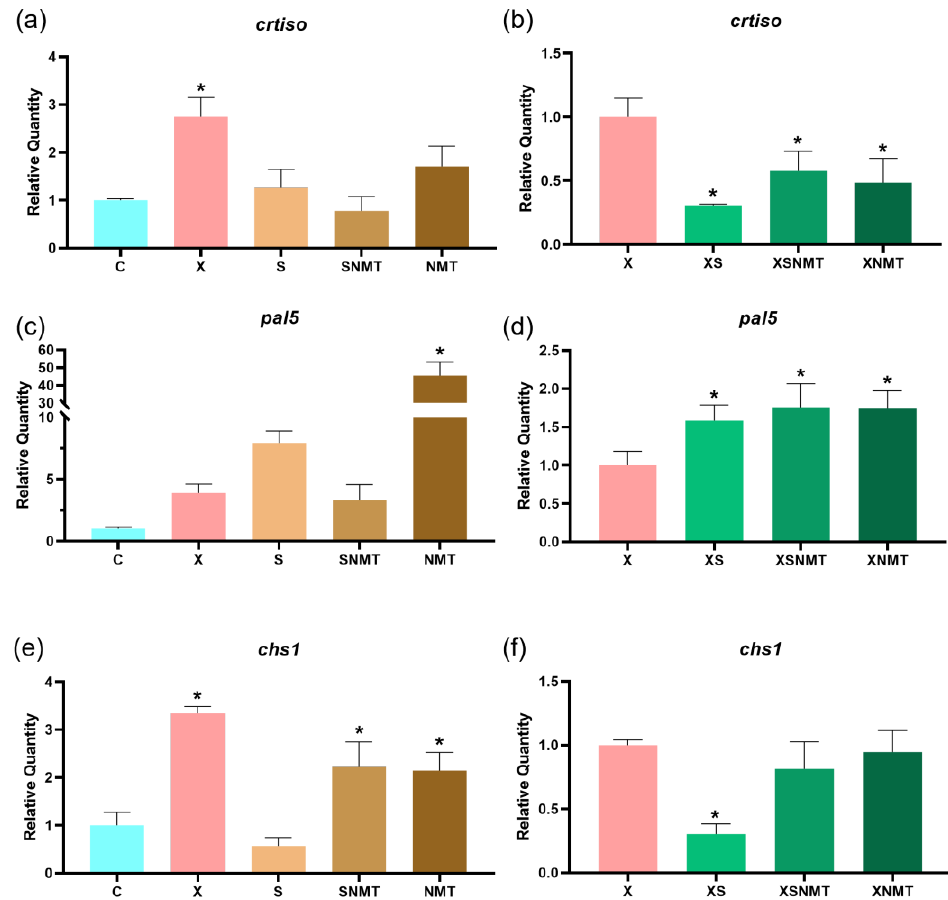
Figure 4. Expression levels of genes related to the carotenoid ( crtiso ) and the phenylpropanoid pathway ( pal5 and chs1 ), quantified by RT-qPCR. ( a , c , e ) represent the levels of the uninfected/treated groups, plus the positive control (X), compared to the uninfected/untreated control (C); ( b , d , f ) represent the levels of the infected/treated groups compared to the positive control (X). All values are presented as mean ± SD ( n = 3). Means marked with “*” are statistically different according to the Dunnett comparison test ( p < 0.05). C: uninfected untreated shoots; X: infected untreated shoots; S: uninfected shoots treated with S. montana EO; SNMT: uninfected shoots treated with S. montana EO + NMT formulation; NMT: uninfected shoots treated with NMT; XS: infected shoots treated with S. montana EO; XSNMT: infected shoots treated with S. montana EO + NMT formulation; XNMT: infected shoots treated with